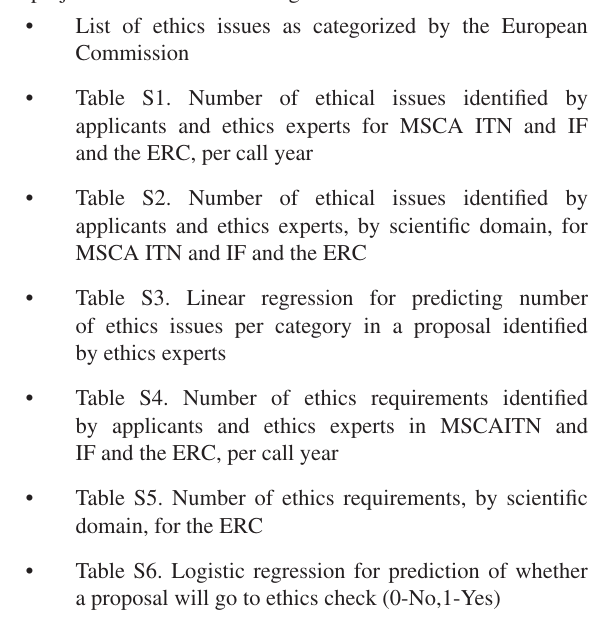
Table S1. Number of ethical issues identified by